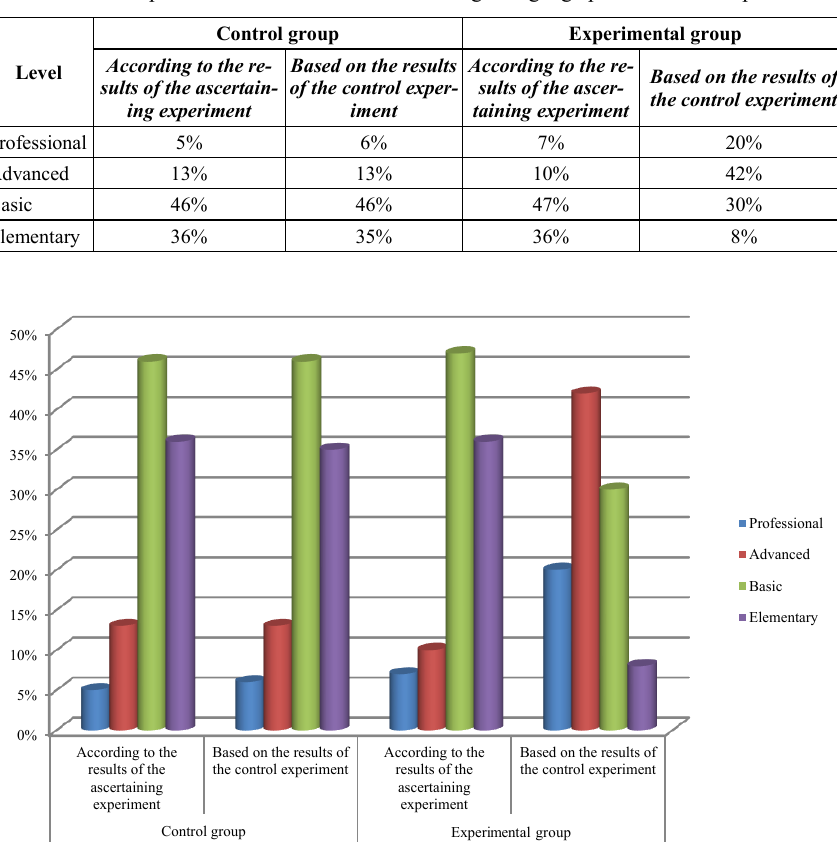
Table 4. Comparative levels of formation of foreign-language professional competence.